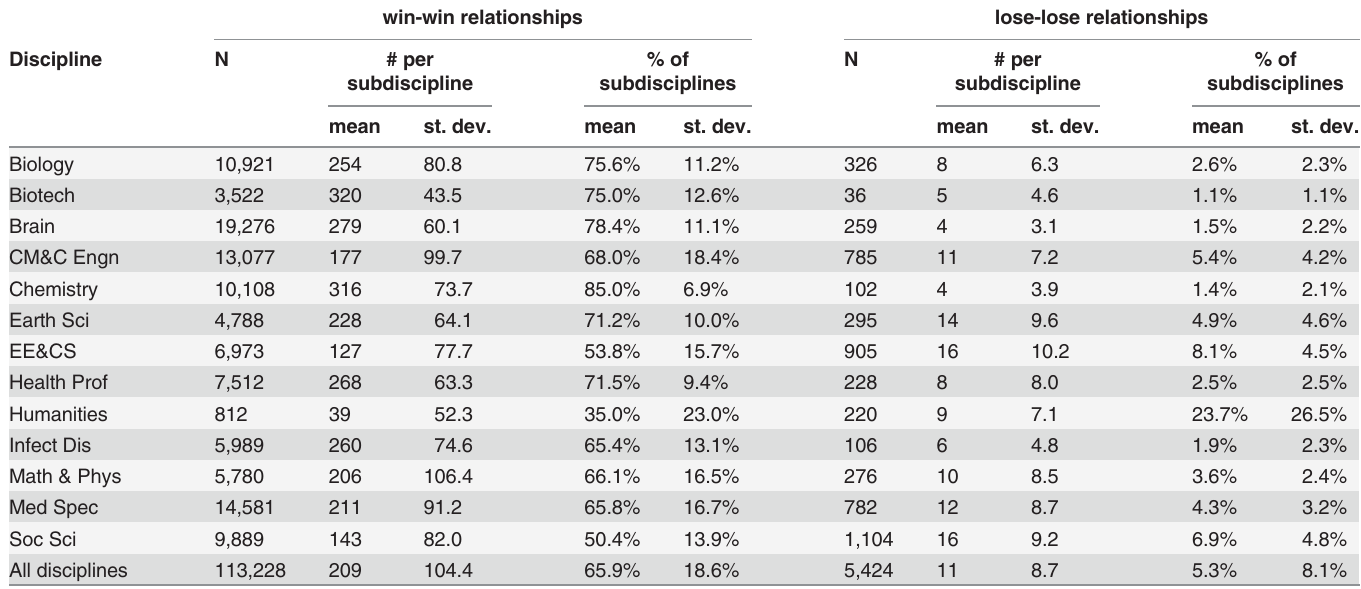
Table 3. Number, mean number and mean percentage of win-win and lose-lose relationships per subdisciplines for 13 disciplines. win-win